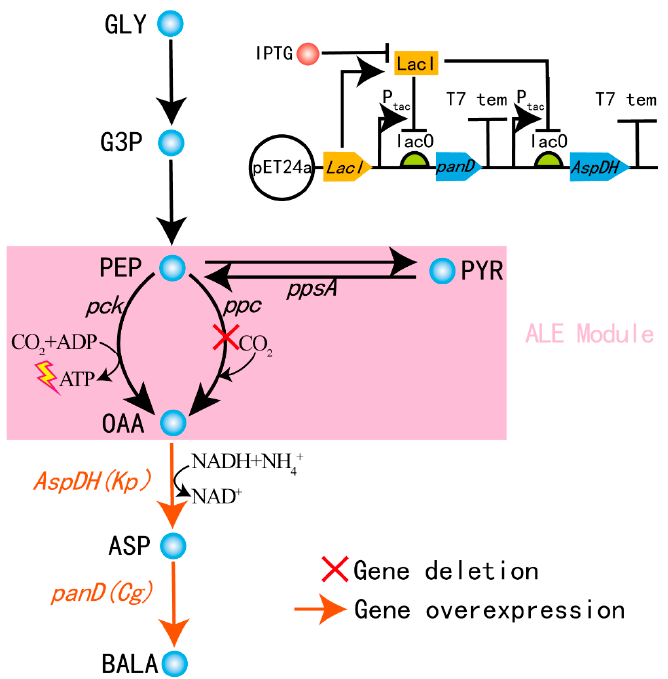
Figure 1. The metabolic pathway designed for the production of β -alanine. The structure of the expression vector pET24a- panD - AspDH is shown beside the metabolic pathway. GLY: glycerol, G3P: glyceraldehyde-3-P, PEP: phosphoenolpyruvic acid, PYR: pyruvate, OAA: oxaloacetic acid, ASP: aspartic acid, BALA: β -alanine.